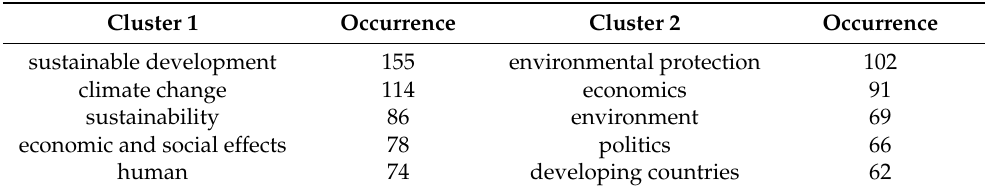
Figure 6. Co-occurrence of keywords. (1201 documents, occurrences ≥ 20; 2 clusters, 68 keywords). Table 8. Top 10 keywords. Cluster 1 Occurrence Cluster